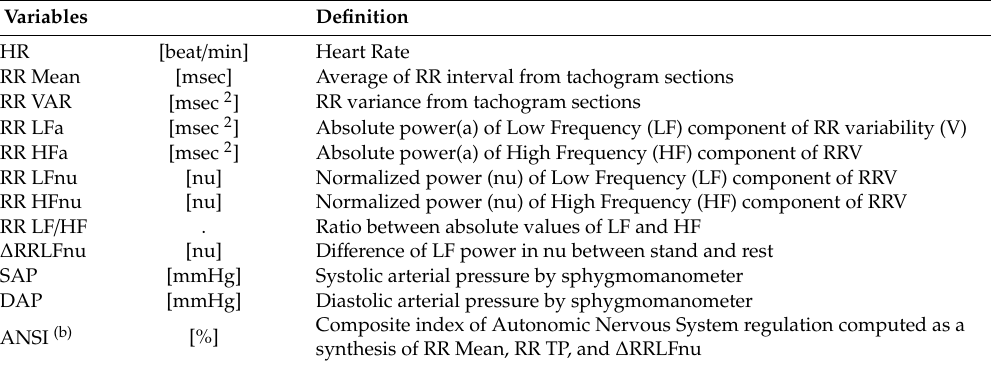
Table 1. Definition of the variables (ANS proxies) employed in the study (a)